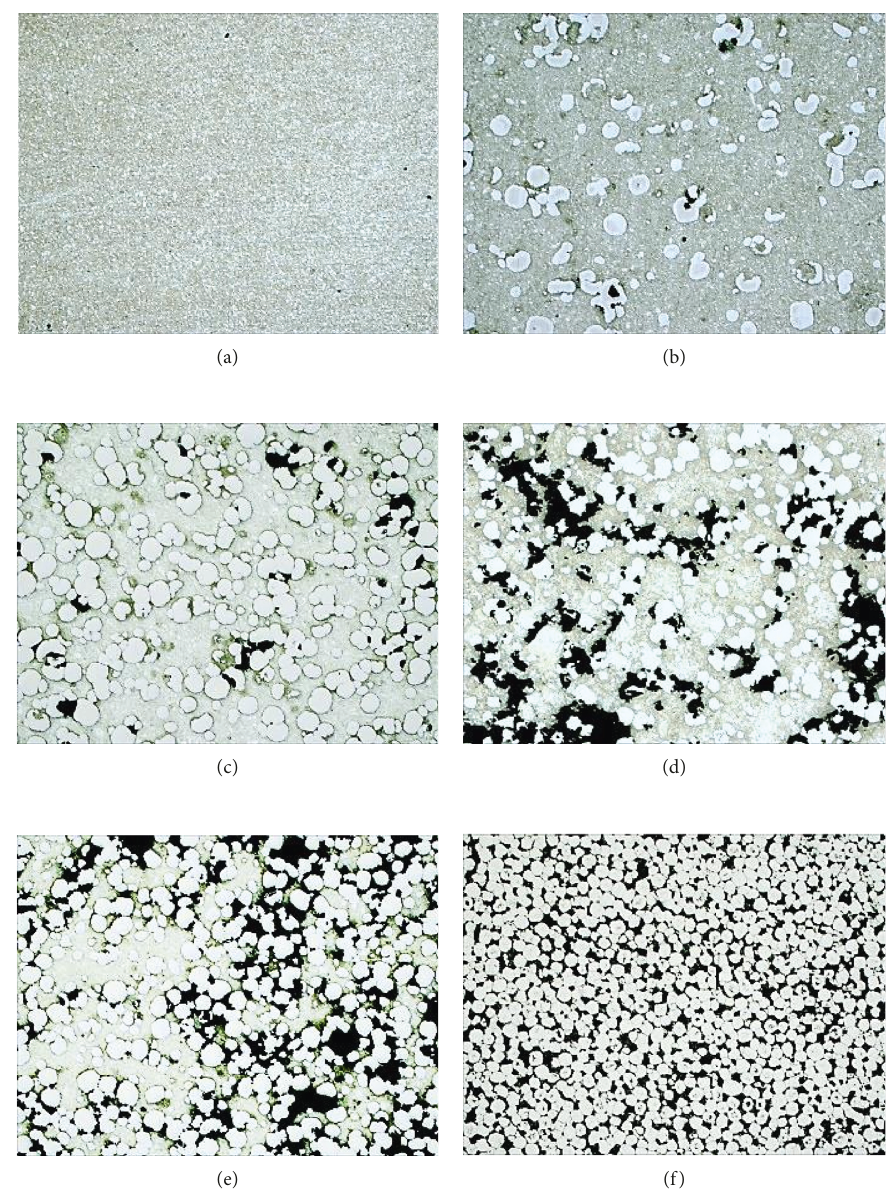
Figure 5: Optical microstructures obtained at 5x of the system Zn-Ni x : (a) Zn, (b) Zn-Ni 5 , (c) Zn-Ni 10 , (d) Zn-Ni 15 , (e) Zn-Ni 20 , and (f)